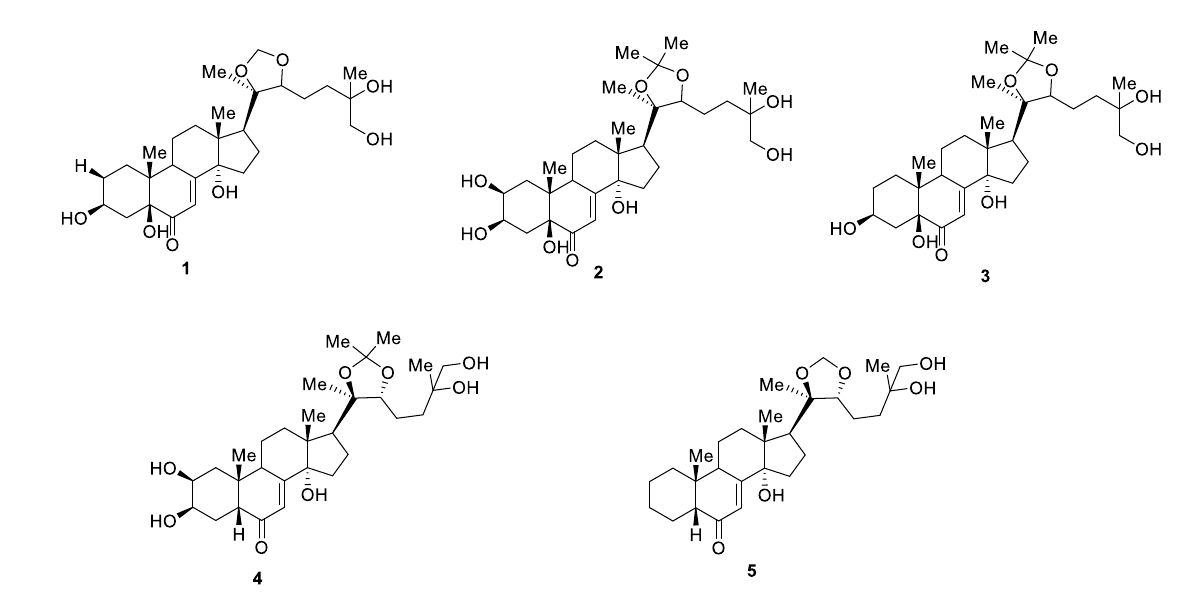
Figure 2. Formulas of compounds present in the extract of callus, cell suspension, and root cultures of Rhaponticum carthamoides , identified by NMR spectra (the formula number corresponds to the peak number).